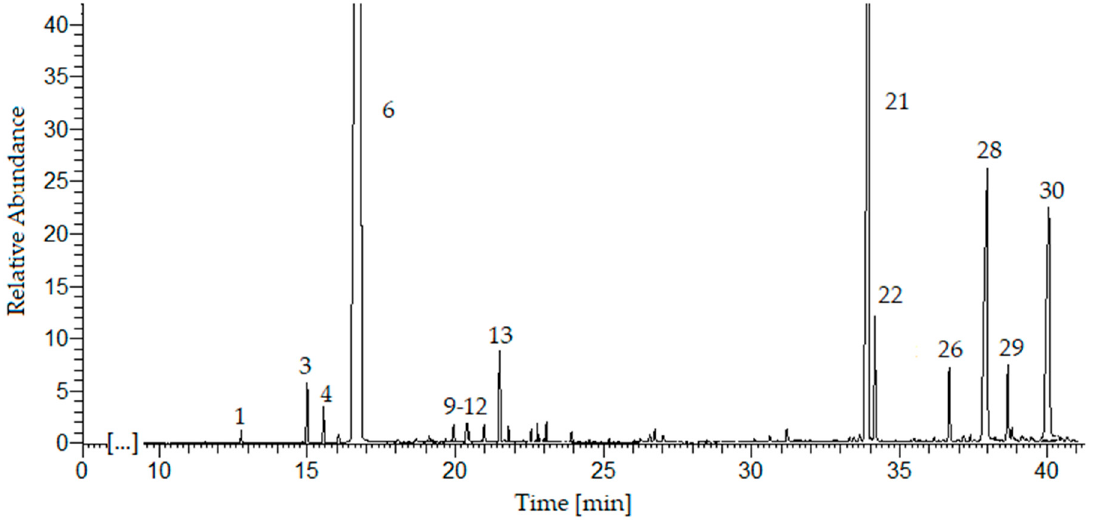
Figure 2. GC-MS chromatogram of the essential oil from sonicated celery seeds ( Apium graveolens L.). For peak identification, see Table 3.